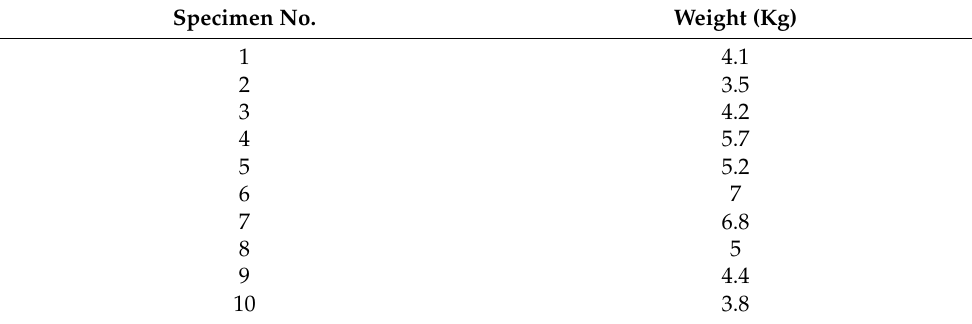
Table 1. The initial weight of the rabbits.